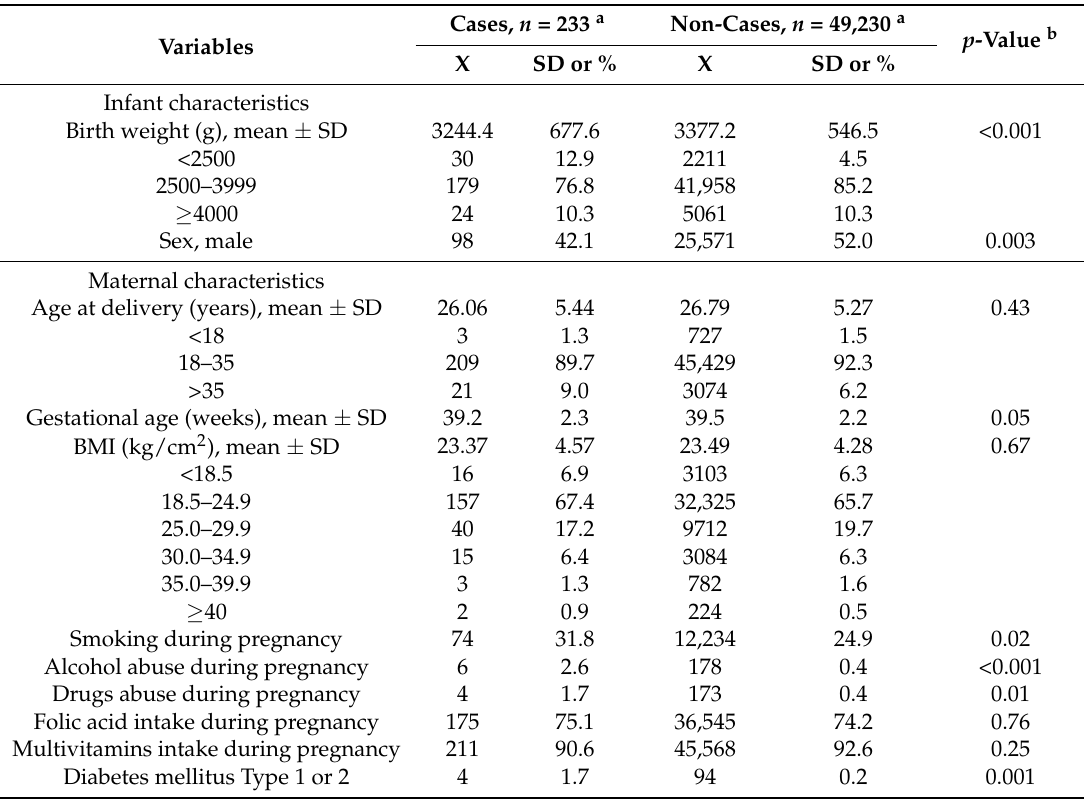
Table 3. Characteristics of the groups with ventricular septal defects (VSDs) and those without any CVMs (Q21) for the combined data set of newborns registered in the MCBR and the MRCDR during the period 2006–2011.